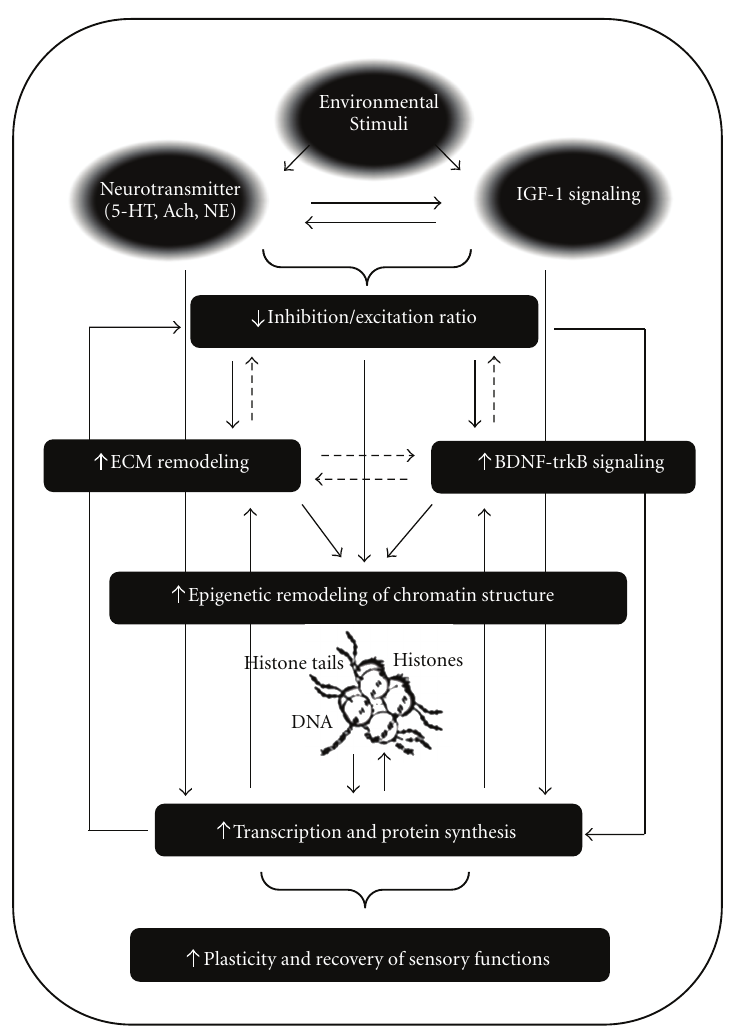
Figure 3: The process of plasticity reactivation induced by EE is associated with signal transduction pathways that involve the activation of long-distance neuromodulatory systems and IGF-1 signaling. We propose a model in which the interplay between 5-HT and IGF-1 transmission, in parallel or in series, shifts the inhibitory/excitatory balance in favour of excitation thus activating intracellular mechanisms that eventually promote epigenetic modifications of chromatin structure that, in turn, allow for the expression of plasticity genes in adult life. A pharmacological reduction of inhibitory transmission could promote Bdnf expression and activate physiological mechanisms that may drive the degradation of extracellular matrix (ECM) components that are inhibitory for plasticity. 5-HT and IGF-1 signaling, respectively, may also directly activate Bdnf expression or enhance the ECM remodeling. Bdnf-trkB signaling might upregulate additional gene expression patterns associated with functional modifications in the VC. This could also alter the balance of intracortical inhibition and excitation. Degradation of ECM components may modify the inhibition/excitation ratio in the visual system. The interaction between BDNF-trkB signaling and ECM reorganization has yet to be explored. Continuous arrows represent established interactions between molecular and cellular processes mentioned (boxes). Dashed lines represent interactions that remain to be